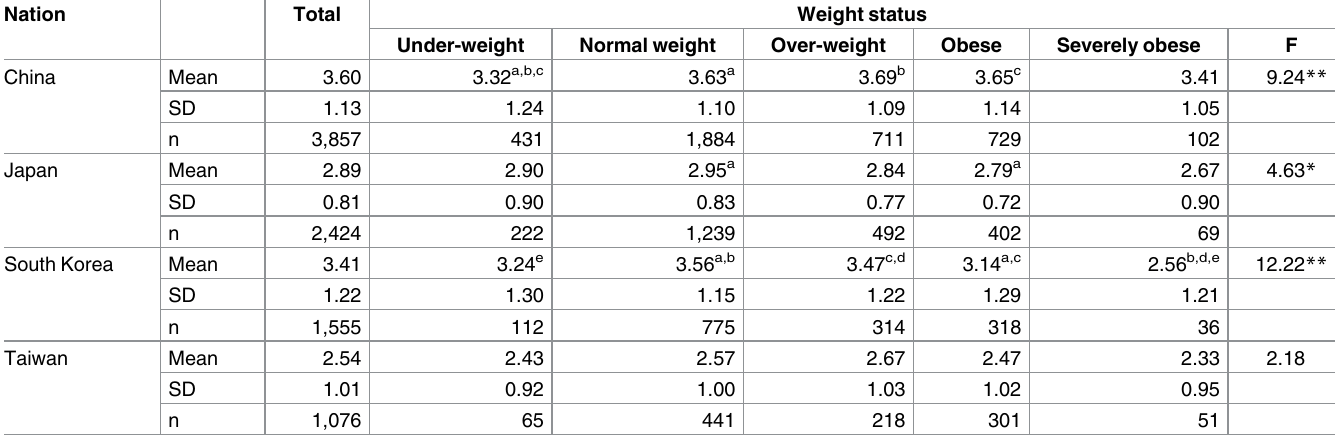
Table 2. Summaryof self-rated health status and weight status by